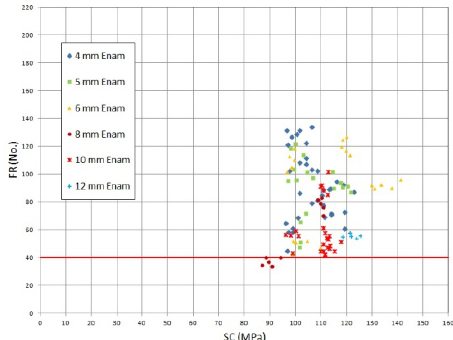
Fig. 4. Correlation of surface compressive stress (SC) versus fragmentation (FR) for enamelled